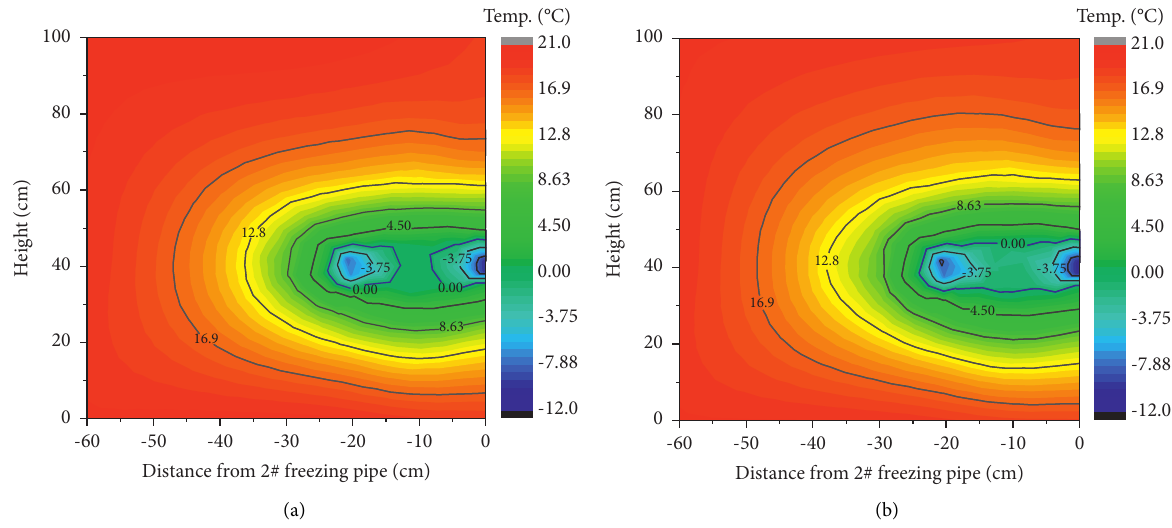
Figure 9: Temperature field of gravel formation under a nonseepage flow. (a) Freezing duration of 8 h. (b) Closure time of frozen wall 9.8h.